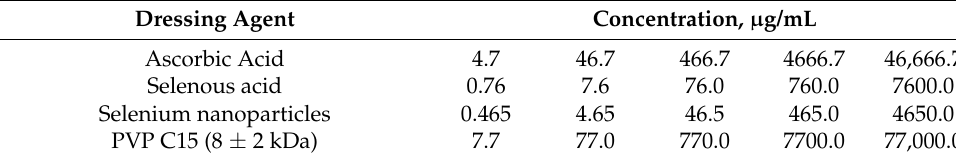
Table 1. Concentrations of substances in seed treatment